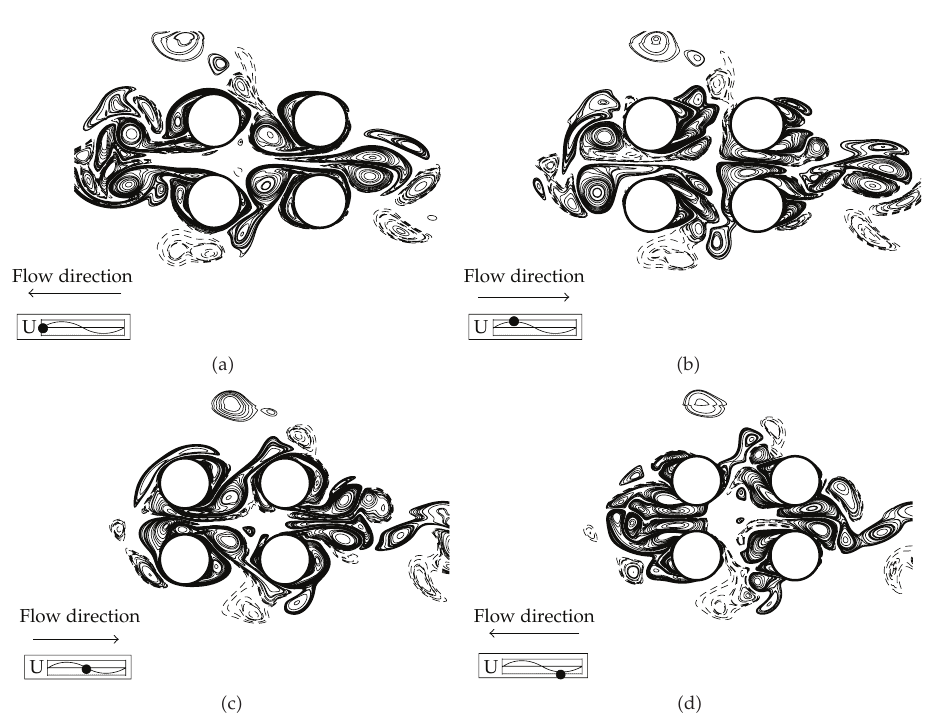
Figure 8: Snapshots of vorticity contours in the oscillatory flow interacting with four cylinders during a cycle at KC (cid:8) 5 and Re (cid:8)